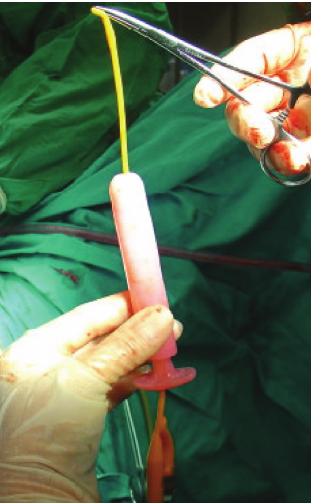
Figure 5: The specially designed vaginal mold with an 8-french pediatric Foley catheter placed in its central